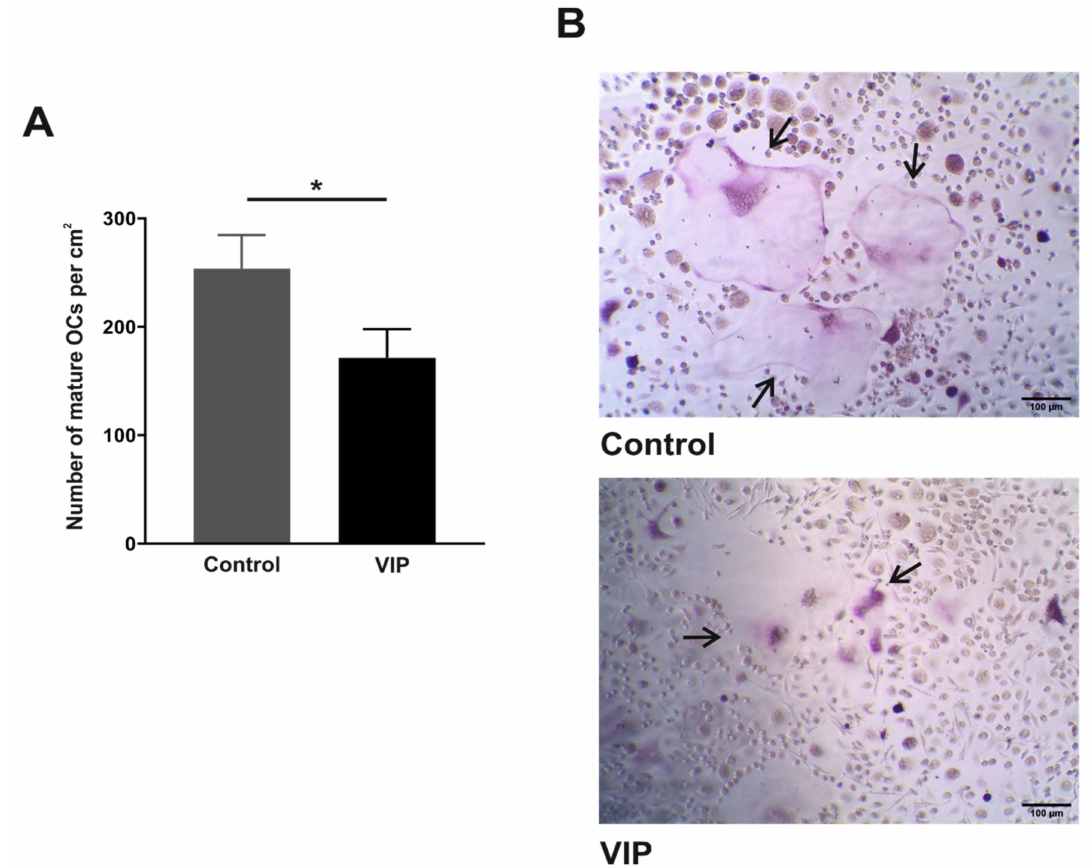
Figure 2. Effect of VIP on osteoclast differentiation. After 14 days of in vitro differentiation osteoclasts were TRAP stained and Hematoxylin was used to visualize the nuclei. TRAP+ cells with 3 or more nuclei were counted. ( A ) Effect of VIP on mature osteoclast number. ( B ) Photomicrographs of the effect of VIP on osteoclast formation. Osteoclasts are indicated with black arrows. The means ± SEM of triplicate determinations of 12 independent experiments are shown. Mann–Whitney U test was performed (* p <